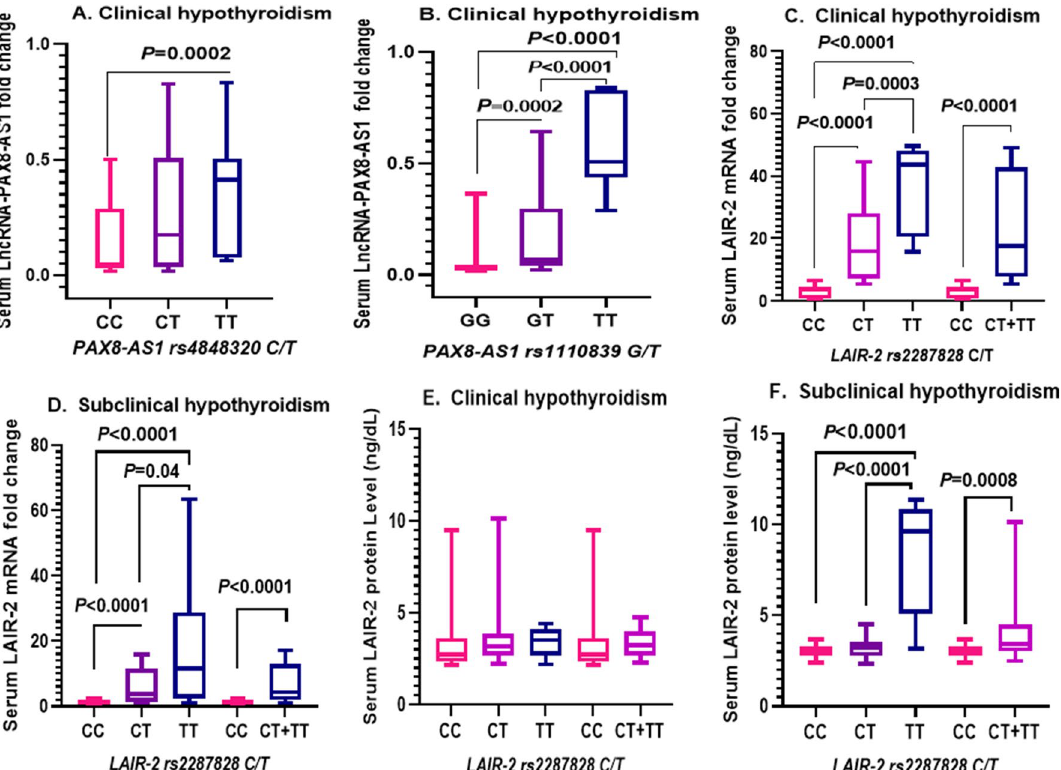
Figure 2. Influence of studied SNPs on the gene expression of LncRNA-PAX8-AS1, LAIR-2 mRNA and protein in hypothyroidism patients. ( A , B ) Fold change of serum expression levels of LncRNA-PAX8-AS1 in different LncRNA-PAX8-AS1 rs4848320 genotypes (CC, n = 30, CT, n = 56, TT, n = 14) and rs1110839 genotypes (GG, n = 22, GT, n = 57, TT, n = 21) in clinical hypothyroidism patients, respectively. ( C , D ) Fold change of serum expression of LAIR-2 mRNA, ( E , F ) Serum LAIR-2 protein concentrations in different LAIR-2 rs2287828 genotypes in clinical hypothyroidism (CC, n = 30, CT, n = 54, TT, n = 16) and subclinical hypothyroidism (CC, n = 47, CT, n = 47, TT, n = 16) patients, respectively. Data are expressed as box blot; the box represents the 25–75% percentiles; the line inside the box represents the median and the upper and lower lines representing the 10–90% percentiles. P < 0.05 means statistical